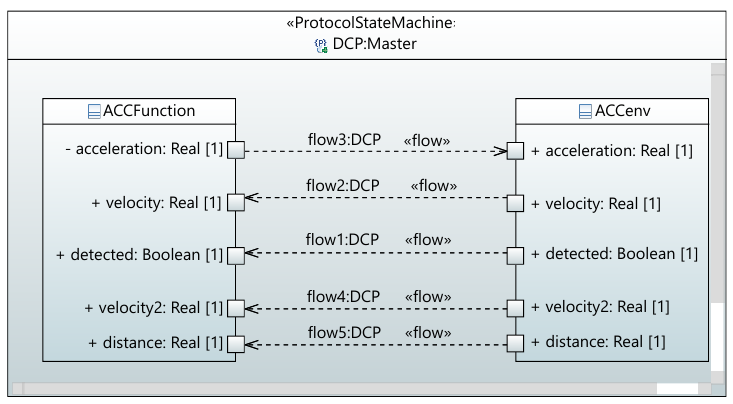
Figure 5. System of the ACC use case described in